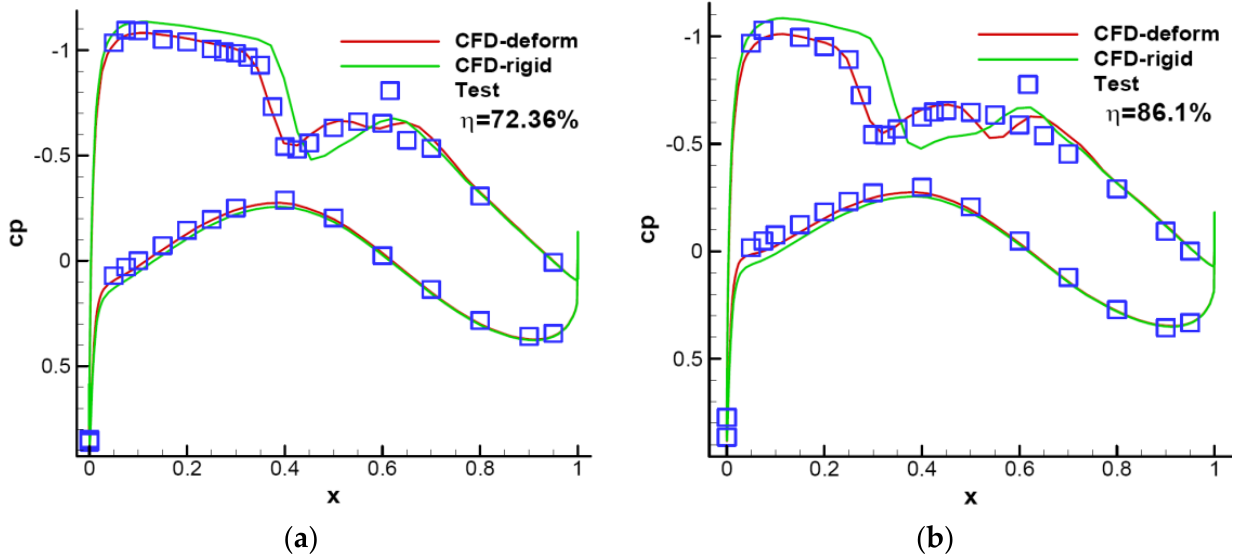
Figure 9. Comparison of surface pressure distributions from CFD and ETW wind tunnel tests (M = 0.76, Re = 15 × 10 6 , α = 2°): ( a ) η = 72.3%; ( b ) η = 86.1%.